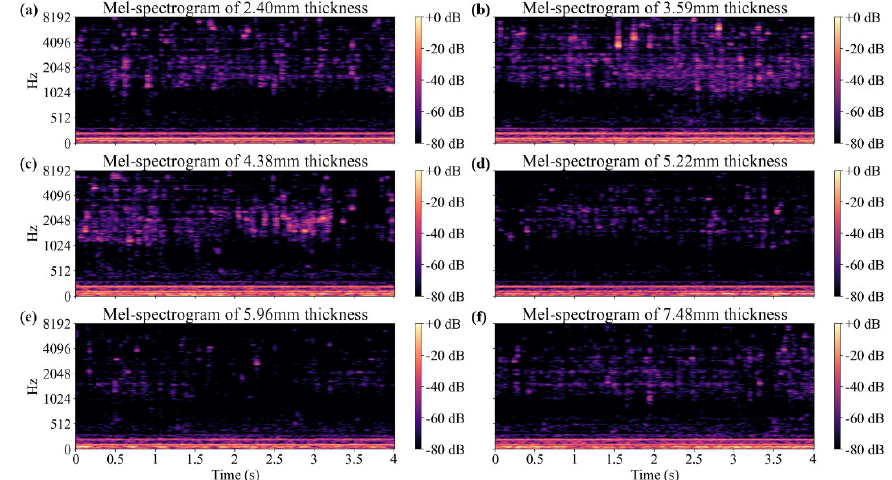
Figure 3. Mel-spectrograms calculated with 256 mel-filters from the acceleration measured at 22.5 degrees of ( a ) 2.40 mm, ( b ) 3.59 mm, ( c ) 4.38 mm, ( d ) 5.22 mm, ( e ) 5.96 mm, and ( f ) 7.48 mm thickness specimens.